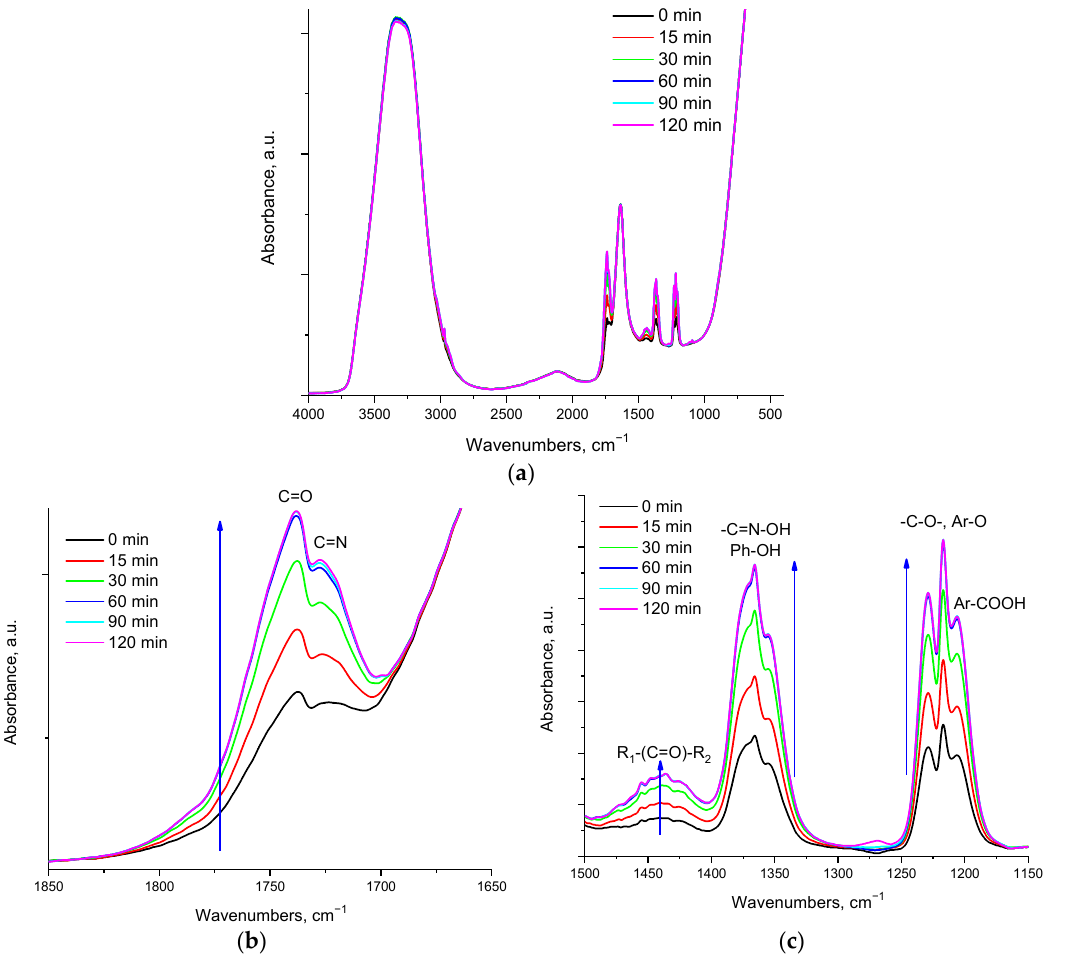
Figure 9. FTIR spectra of amoxicillin solution in the presence of P7 sample at each reaction time: ( a ) full spectra, ( b ) 1850–1650 cm − 1 region, ( c ) 1500–1150 cm − 1 region.